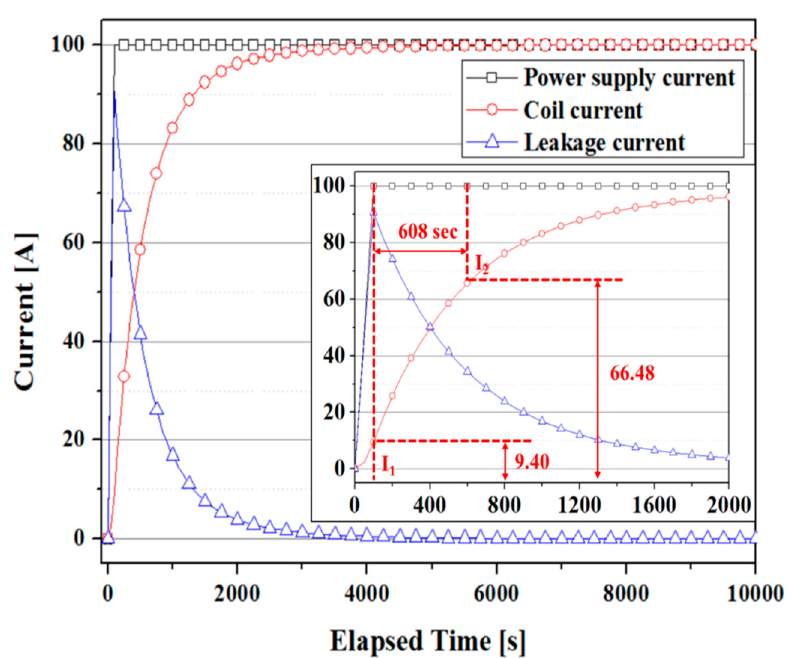
Figure 10. Field-circuit coupled finite element method (FEM) model of the designed NI HTS FSM.